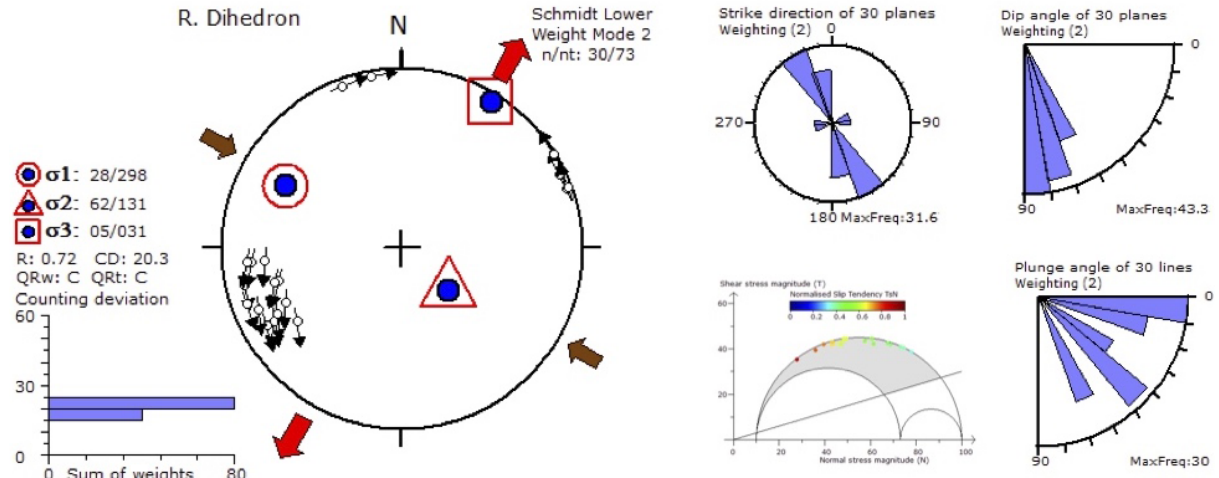
Figure 10. Paleostress analysis (using the right dihedron method) of faults recorded in the metabasalts of the study area for both left lateral and right lateral normal faults. Red arrow marks the extension direction ( σ 3 ) and brown arrow marks the principal compression direction. The histogram shows the minimum values for counting deviation. n and nt are the number of data accepted for tensor calculation and total number of data, respectively. R (stress ratio) = (σ 2 − σ 3 )/(σ 1 − σ 3 ) . Rose diagrams for fault plane strike, dip and plunge variations are also presented in the top right corner. Three-dimensional Mohr diagrams demonstrate possible areas of fault reactivation with variation in susceptibility; colored circles represent the pole to the fault planes. The failure envelope for Mohr’s circle is based on a Byerlee (1978) initial friction angle of 16.7 ◦ . Note that the maximum extension is along the NNE–SSW